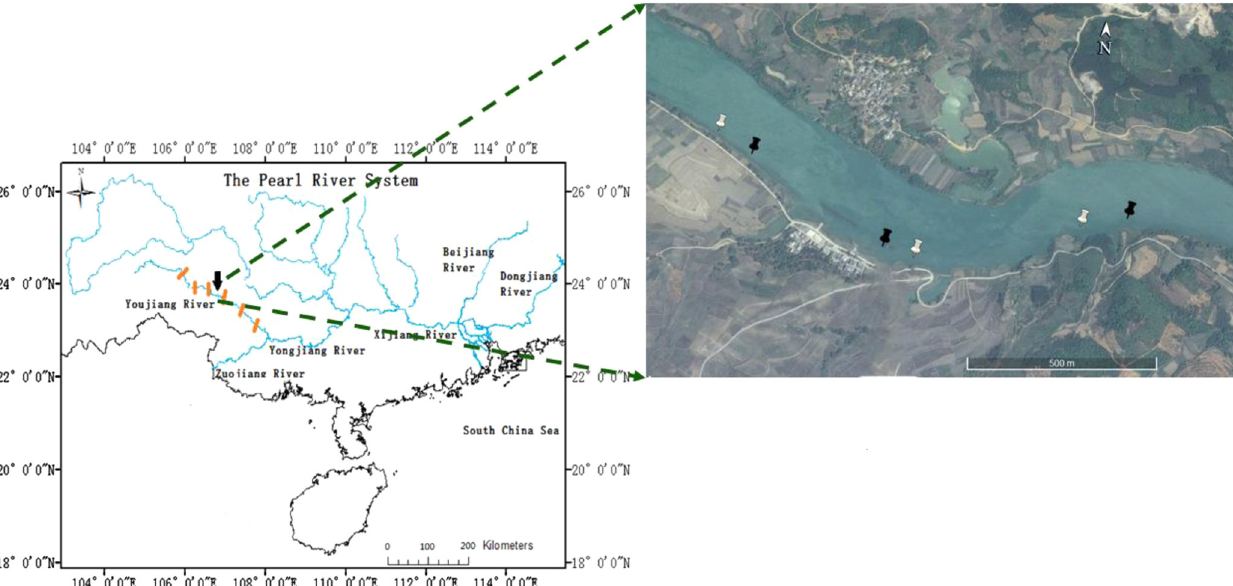
Fig. 1. Map of the study site in the Pearl River, China. Solid black arrow indicates the study site and golden bars indicate dams (Wacun Dam, Baise Dam, Dongsun Dam, Naji Dam, Yuliang Dam, Jinjitan Dam from upstream to downstream, respectively) in the Youjiang River. Black pushpins indicate the location of arti fi cial structures and white pushpins indicate control sites. Arti fi cial structures are also shown in the lower- right